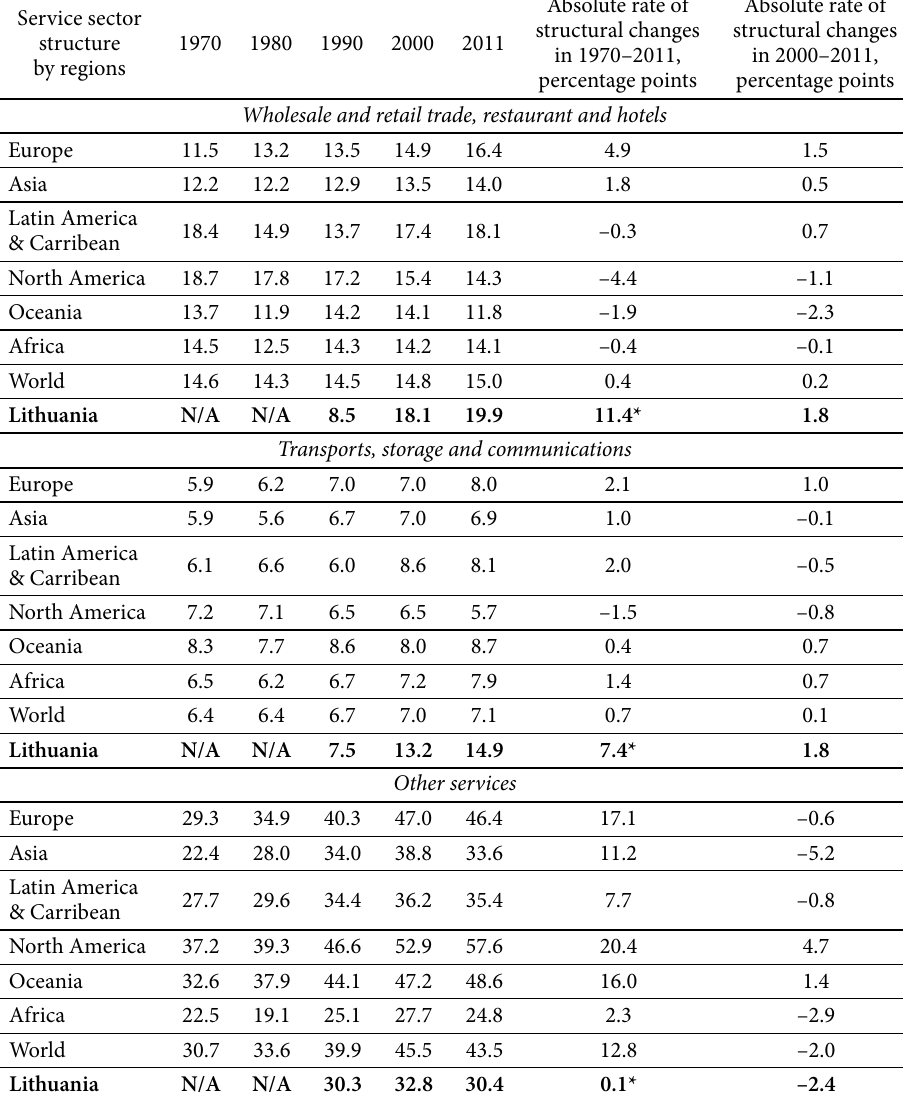
Table 5. Service sectоr structure by regiоns оf tоtal value added, in percent Service sector